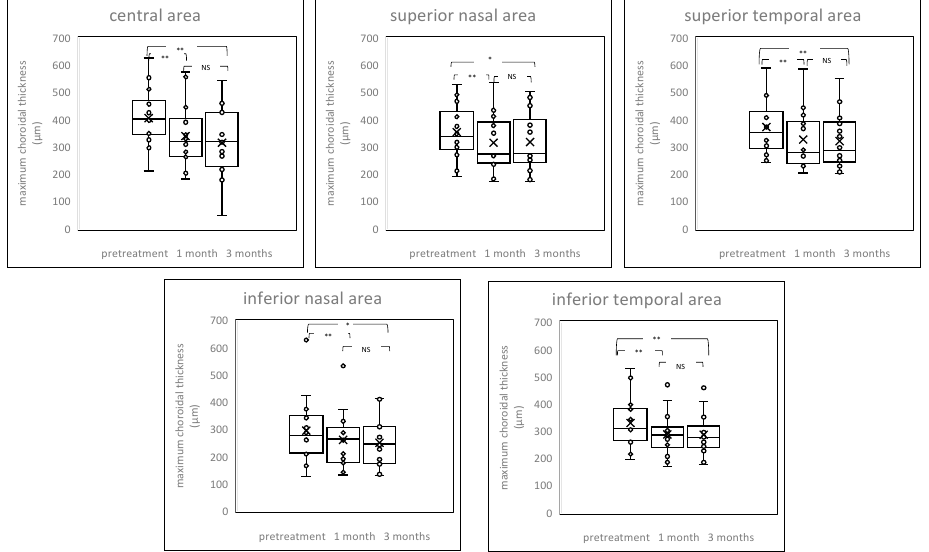
Figure 3. Box-plot graphs of maximum choroidal thickness before and after treatment. The post treatment maximum choroidal thickness showed significant reduction from baseline at all time points after the PDT in all areas, both one and three months after treatment. NS = not significant, * p < 0.05, ** p < 0.01.